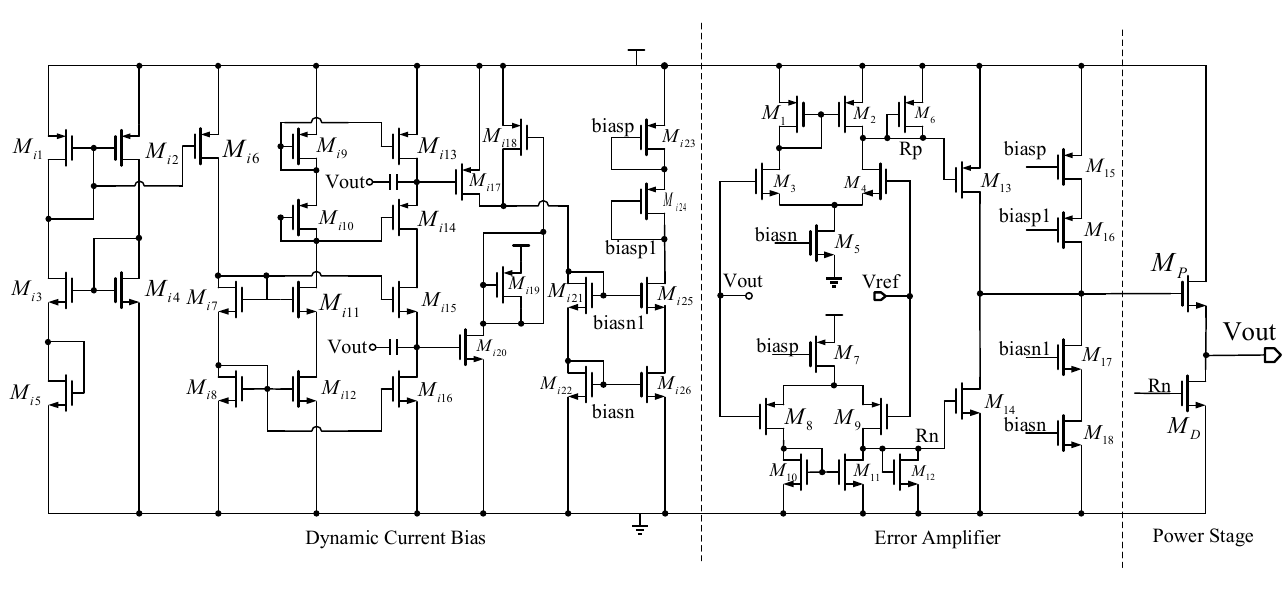
Figure 2. Schematic of the proposed LDO.